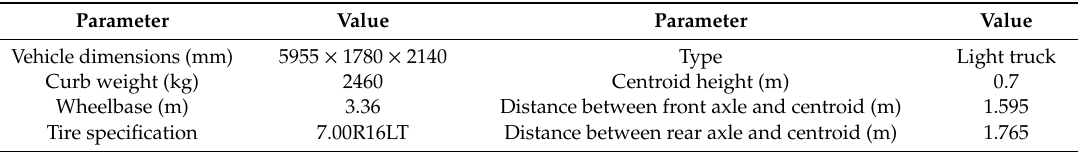
Table 1. Commercial vehicle parameter table.